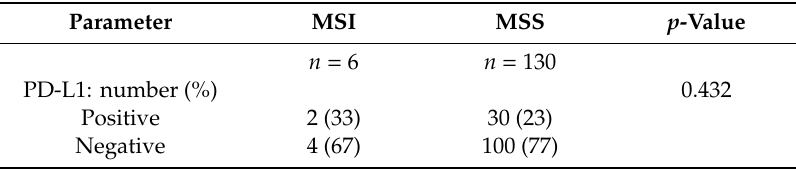
Table 3. Relationship between MSI status and PD-L1 expression.